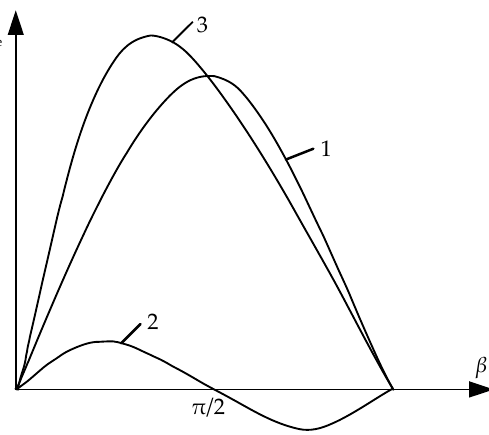
Figure 5. The relationship between torques and torque angle.